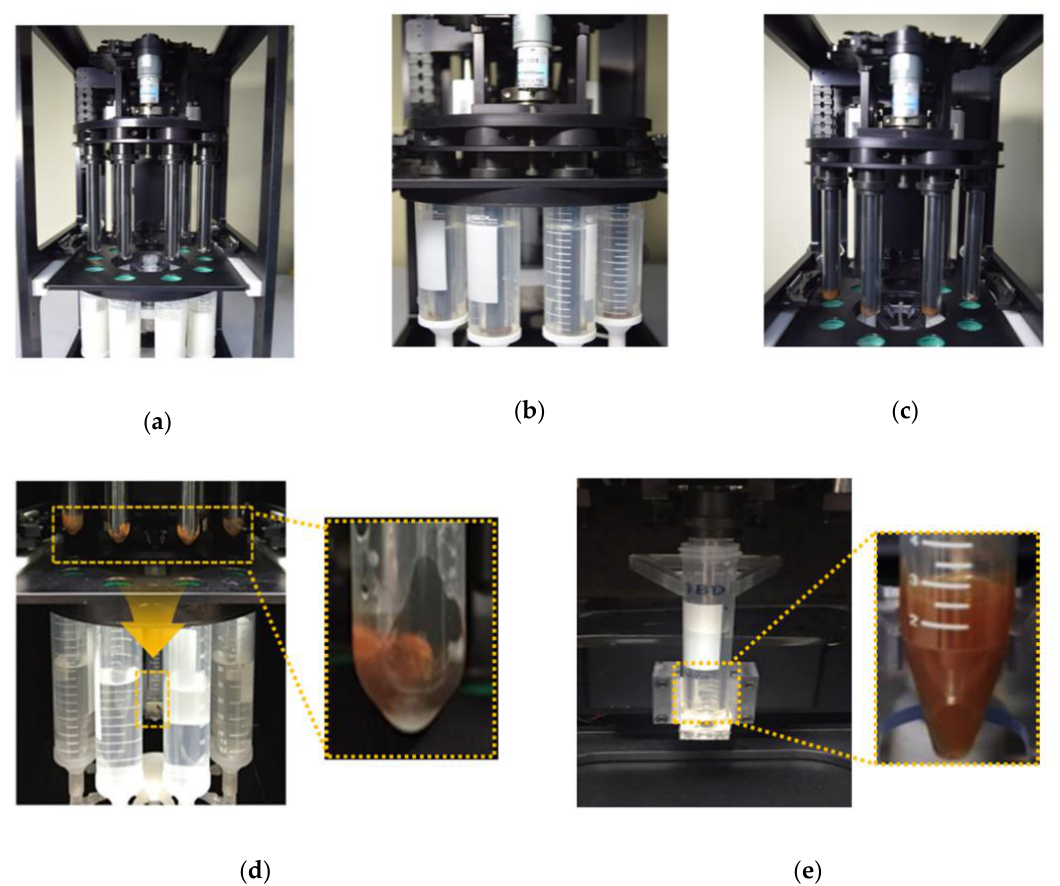
Figure 2. Representative step-by-step images of the automated IMS process: ( a ) Introduction of a pre-enriched sample containing immunomagnetic beads bound with target bacteria in a milk sample; ( b ) Separation of immunomagnetic beads from the sample solution using an inserted magnetic bar; ( c ) Removal of the adhered magnetic beads along with the target bacteria from the sample solution; ( d , e ) Immersion of each glass cylinder in to the recovery tube containing 2 mL of buffer solution and redispersion of the magnetic beads and bacteria by vertical movement (two times repetition).